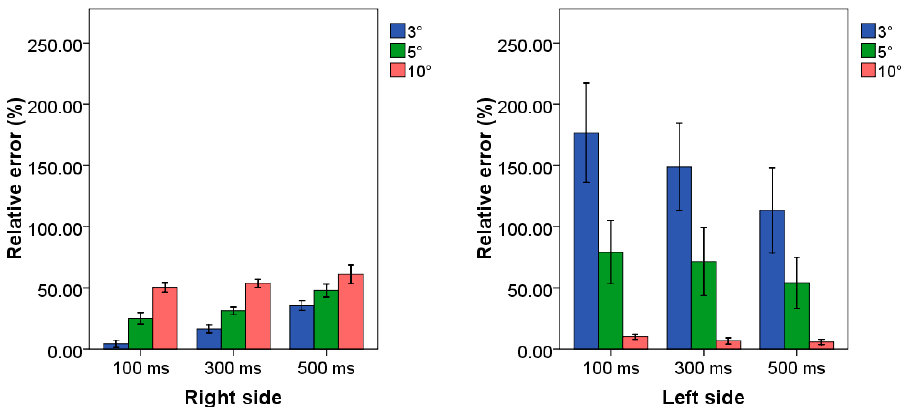
Figure 6. Mean value and standard deviation of relative error related to the case study at higher frequency for both side of all combinations of TB procedure. Blue, green and red bars represent the combination in which the threshold amplitude is set to 3°, 5° and 10°, respectively. Clusters on the x -axis represent the possible time threshold value. Each bar corresponds to a specific combination among the nine tested algorithms.